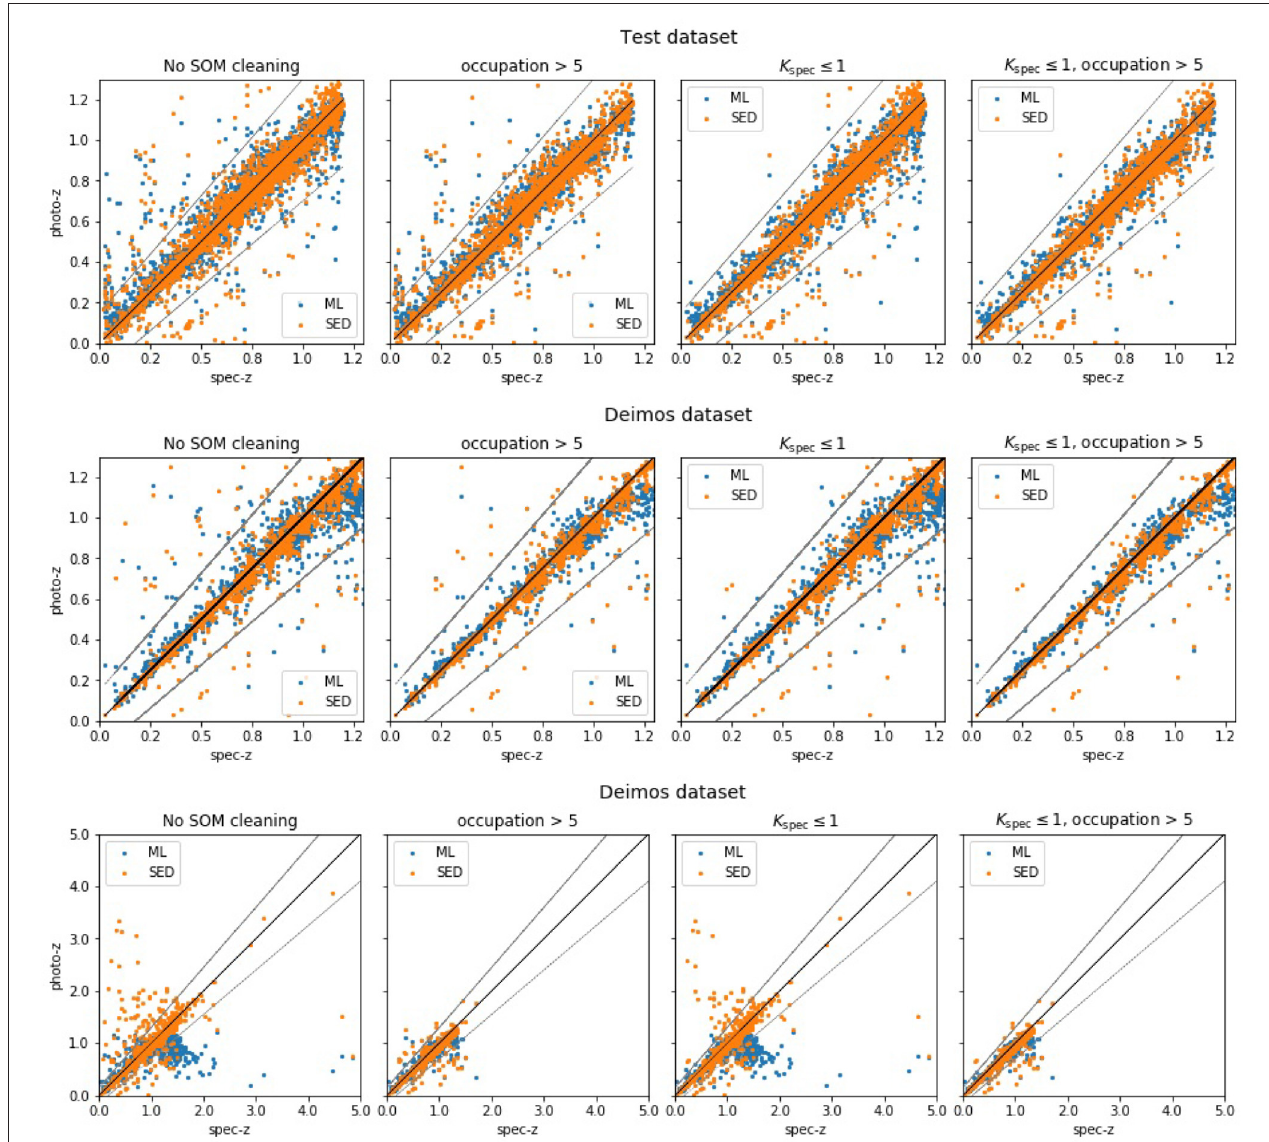
FIGURE 8 | Figure from Razim et al. (2021). Scatter plots of machine learning (ML) and SED fitting photometric ( photo z ) against spectroscopic ( spec z ) redshifts. The photo-z were predicted by the MLPQNA neural network, trained on COSMOS spectroscopy and photometry and validated also on DEIMOS spectroscopic catalog. The first left column of panels shows the datasets before SOM filtering. The panels of the second column show the results after having filtered only the spec-z outliers. The third column panels report the plots after the filtering of only occupation maps, while, in the last column, the panels show the datasets after the combination of the two cleaning methods. The dotted lines show outlier boundaries defined as photo z = spec z ± 0.15. The top first two rows show the results for the test and DEIMOS datasets limited to spec z < 1.2 and photo z <